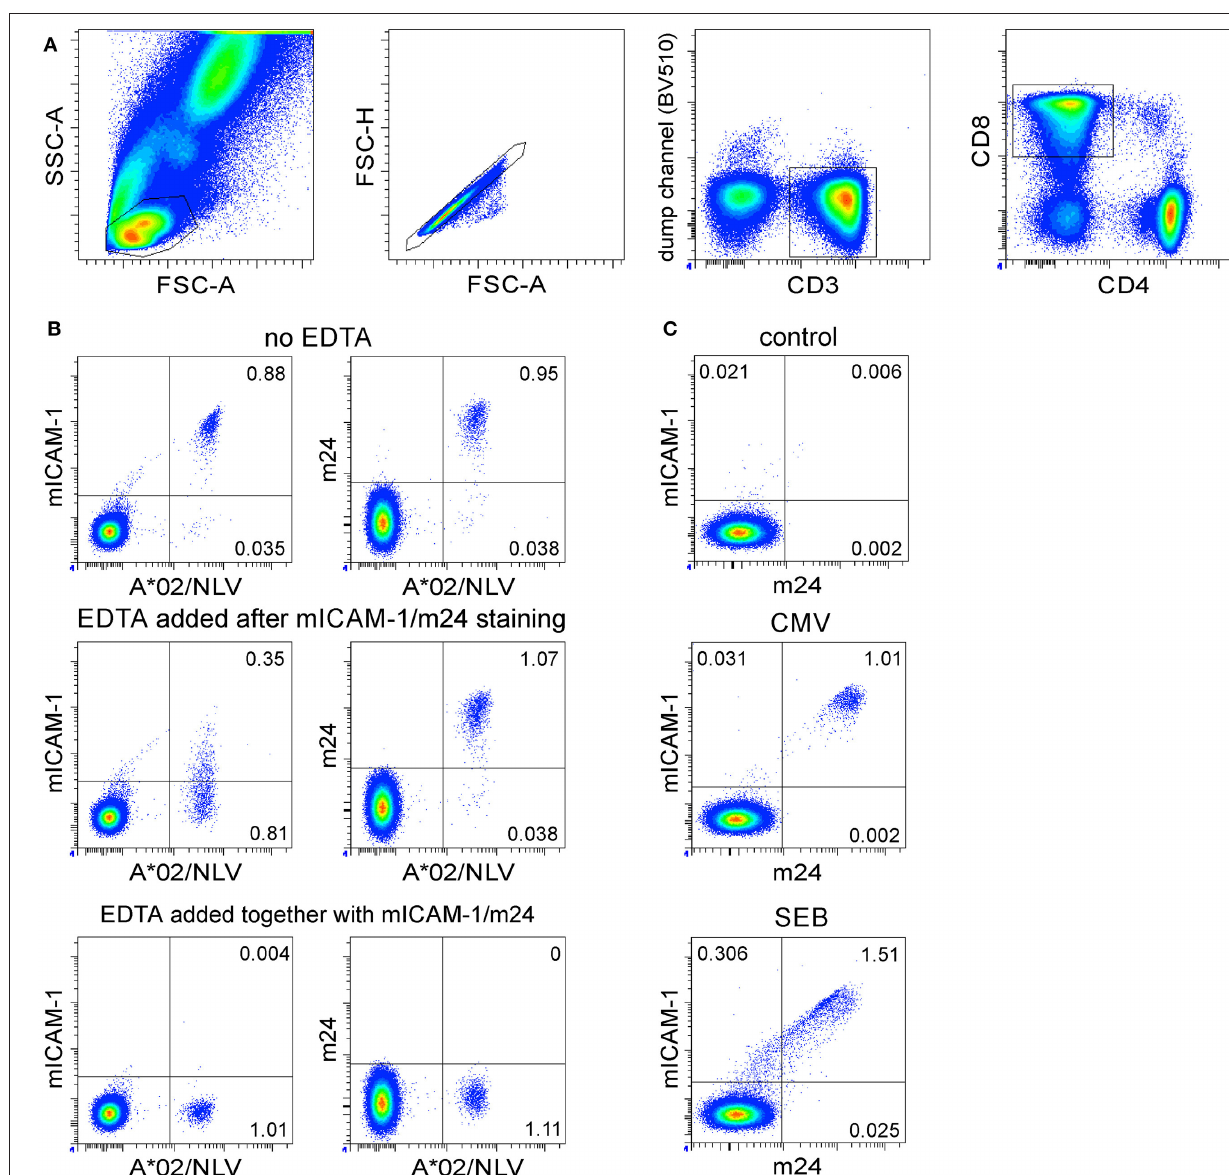
were essentially m24 + , indicating that once the Ab is bound, EDTA does not reverse the binding, as it does for ICAM-1 multimers. When EDTA was added at the time of m24 Ab staining, the cells were m24 neg , showing that EDTA blocked m24 Ab binding to activated β 2 -integrins. Without EDTA treatment, 18% of the CMV/HPT-specific and 50% of the SEB- stimulated TNF + cells were within the lymphocyte or